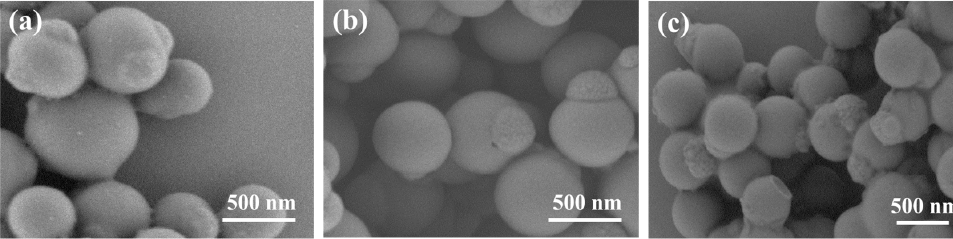
Figure 4. SiO 2 @MPSQ snowman-like particles prepared at different rotational speeds: ( a ) 100 rpm, ( b ) 200 rpm, and ( c ) 400 rpm. ( b ) 200 rpm, and ( c ) 400